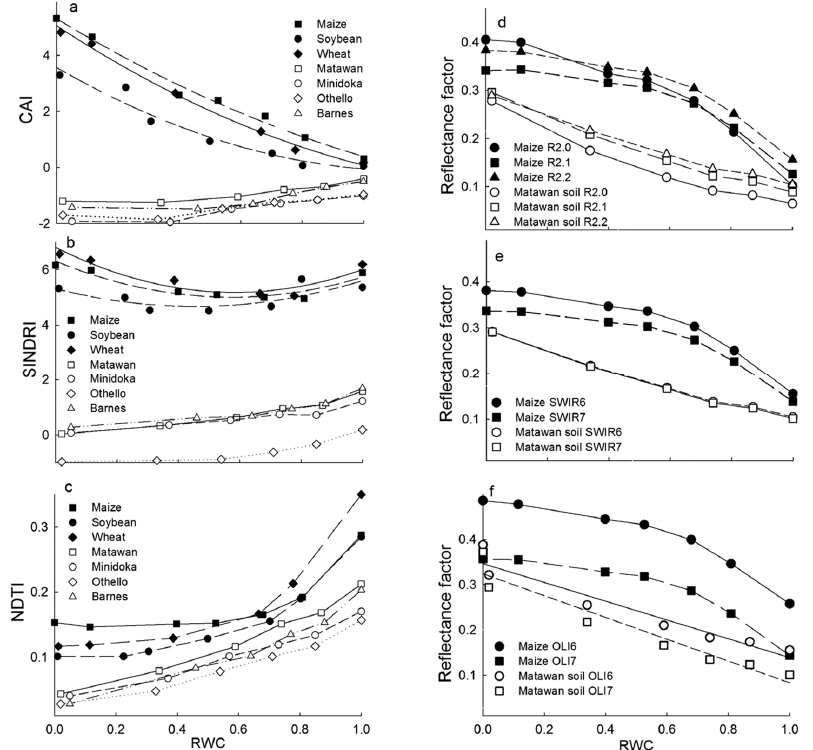
Figure 4. Changes in CAI ( a ); SINDRI ( b ) and NDTI ( c ) of three crop residues and four soils and bands R 2.0 , R 2.1 and R 2.2 ( d ); bands SWIR6 and SWIR7 ( e ) and OLI6 and OLI7 ( f ) of maize residue as a function of relative water content (RWC) based on the spectra collected in the laboratory.